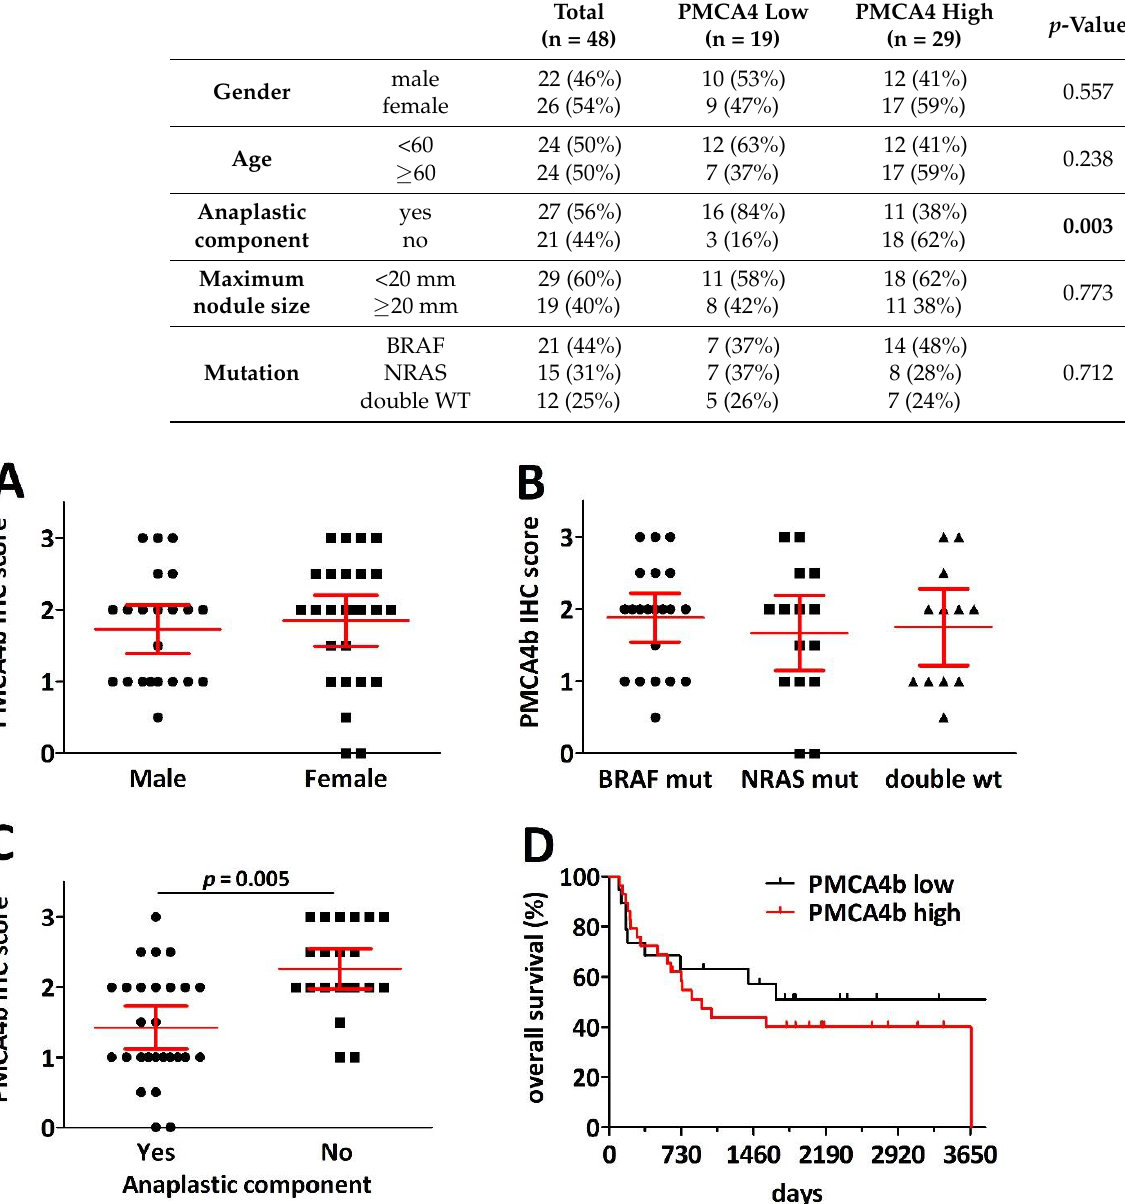
Figure 6. Clinicopathological analysis of PMCA4b protein levels in melanoma lung metastasis. ( A )